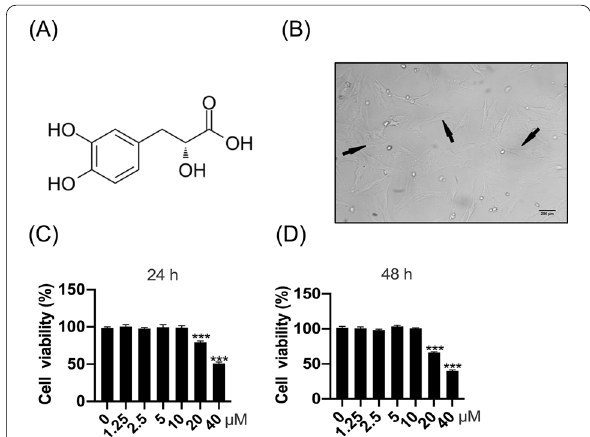
Fig. 1 The cytotoxicity of DSS on chondrocytes. A The structure of DSS. B The morphology of primary chondrocytes. Scale bar C , D Chondrocyte viability was detected by the CCK-8 kit after treatment with different concentrations of DSS for 24 h ( C ) and 48 h ( D ), respectively. ***p <